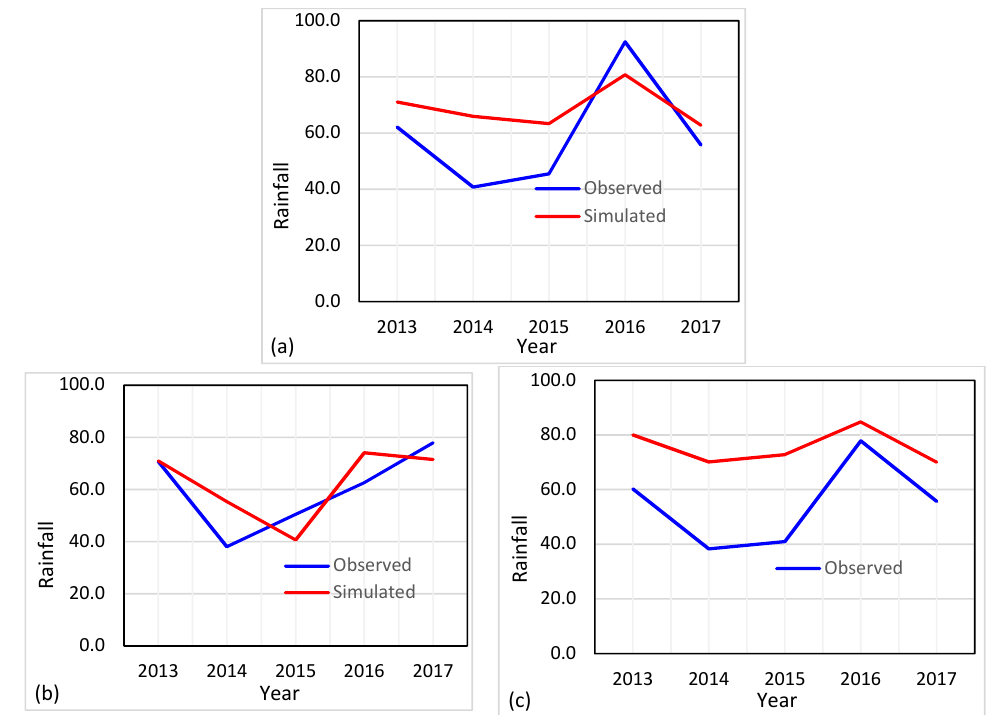
Figure 4. Comparison of the modelling output during the validation period. ( a ) Ainslie Tyson St; ( b ) Tharwa General Store; ( c ) Huntly. Table 5. Estimated statistical parameters during validation period.